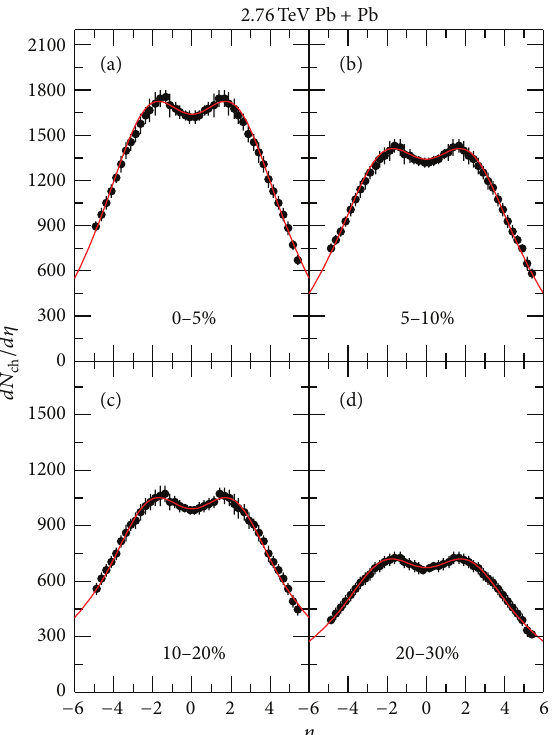
Figure 7: As Figure 1 but showing the results in Cu-Cu collisions at √𝑠 = 200 GeV. 𝑁𝑁